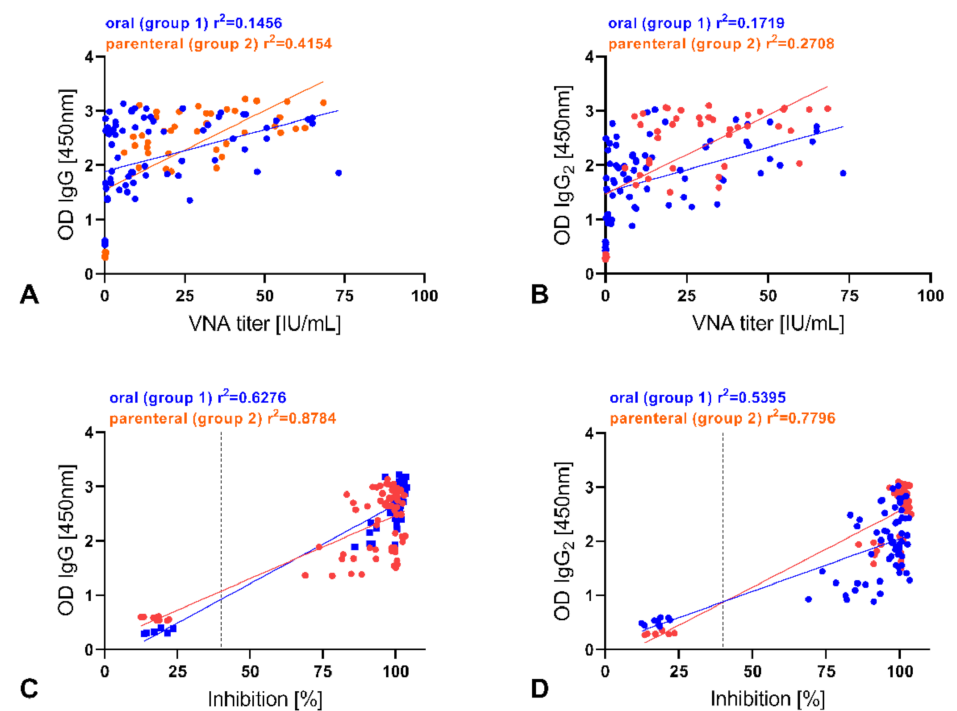
Figure 4. Correlation between RABV-specific VNAs (RFFIT), binding antibodies (ELISA), and RABV- specific IgG and IgG2 in orally and parenterally vaccinated foxes. Pearson correlation coefficients were calculated for VNA titers and IgG ( A ) and IgG2 ( B ) levels as well as between PB and IgG ( C ) and IgG2 ( D ) levels. Dots represent values from an individual animal for different time points (listed in method section). ROUT-test identified real outliers. The vertical dotted line indicates the threshold of positivity in ELISA